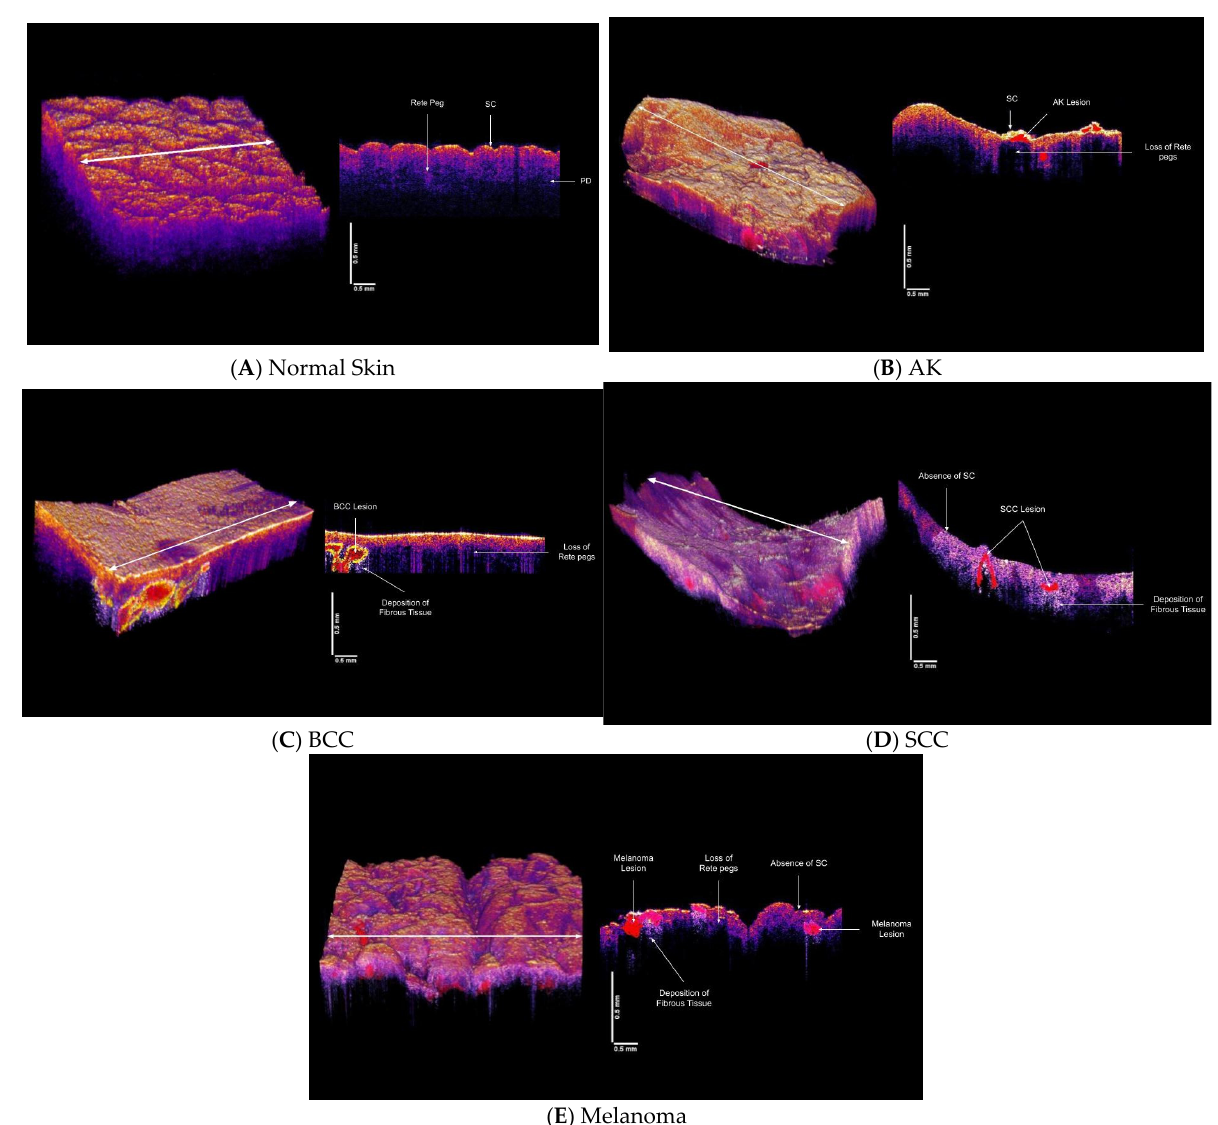
Figure 3. 3D reconstructions of normal skin ( A ), AK ( B ), BCC ( C ), SCC ( D ) and melanoma ( E ) made using OCT images, pixel intensity versus depth data and weighted displacement versus frequency data shown in Figure 2. 3D normal skin reconstruction ( A ) in vivo on the left was created using the volume scan app on the Lumedica OCT and a cross-section of the skin cut at the arrow on the 3D reconstruction in ( A ) (right). The location of the stratum corneum (SC) and rete pegs and the papillary dermis (PD) were identified from the OCT image as reported previously [17,20,21]. An AK lesion ( B ) 3D reconstruction (left) with a cross-section of the lesion on the right. Note the absence of the rete pegs in some areas of the lesion and the presence of the lesion in red. The location and characterization of the lesion were based on the pixel intensity vesus depth plot (Figure 2G) and the weighted displacement versus frequency plot shown in Figure 2L. There is a fibrosis peak at about 180 Hz which is similar to that seen in healing wounds. ( C ) 3D reconstruction of a biopsy with a BCC lesion shown in red (left). The location of the lesion was identified based on data of Figure 2H and the composition was evaluated based on data of Figure 2M. Note the loss of the rete pegs in the cross-section on the left as well as the presence of nodular lesion at the epidermal-dermal junction. Fibrous tissue is deposited below the BCC lesion. ( D ) 3D reconstruction of an SCC (left) based on data shown in Figure 2I,N showing loss of stratum corneum and the presence of SCC lesions (right) and fibrous tissue below the lesion. Note the absence of the rete pegs in some areas and changes in the epidermal-dermal junction. ( E ) 3D reconstruction of a melanoma (right) showing lesions in red on right, and loss of stratum corneum, rete pegs and deposition of fibrous tissue below lesion involving both epidermis and dermis. The melanoma lesion was reconstructed using data from data in Figure